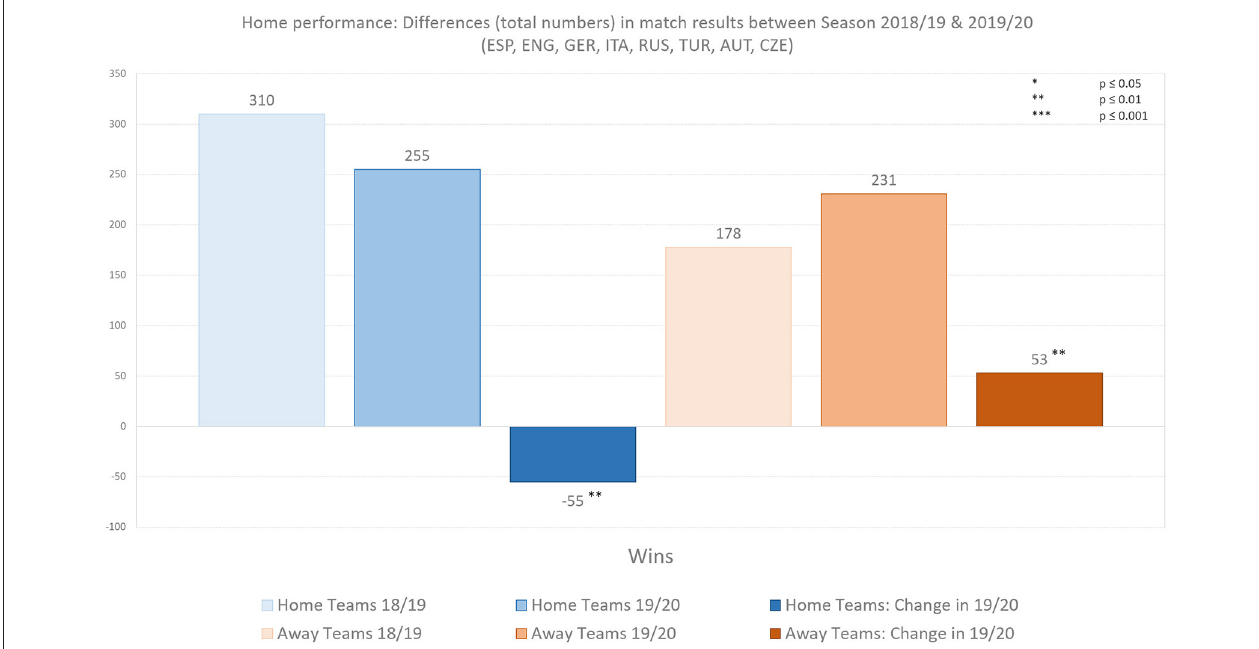
FIGURE 1 | Absolute differences in home performance. Illustration shows the results of home and away teams in the highest football leagues of Spain, England, Germany, Italy, Russia, Turkey, Austria, and Czech Republic.